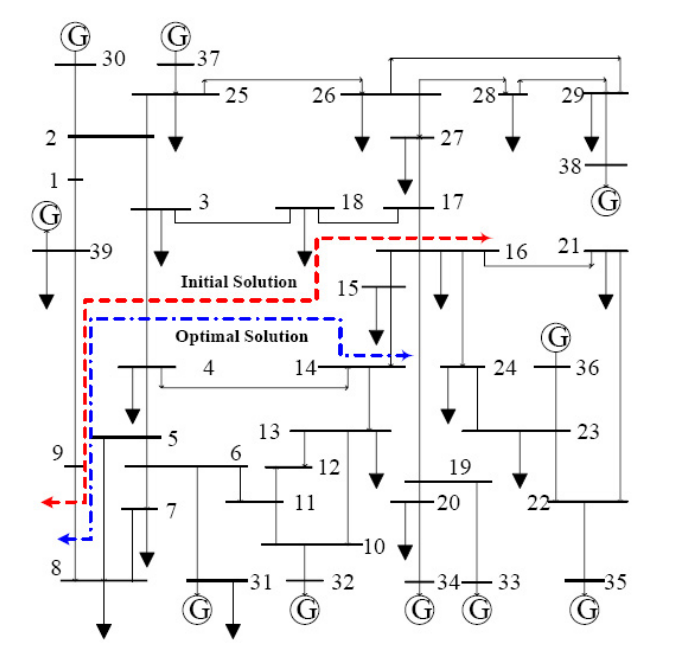
Figure 5. Topology graph of the New England 39-bus